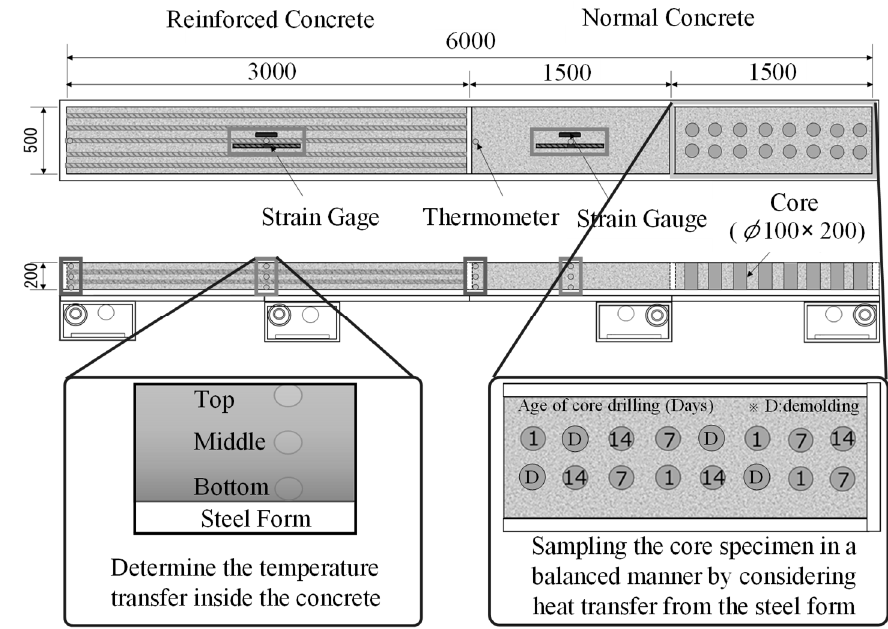
Figure 4. Outline of mock-up specimen.